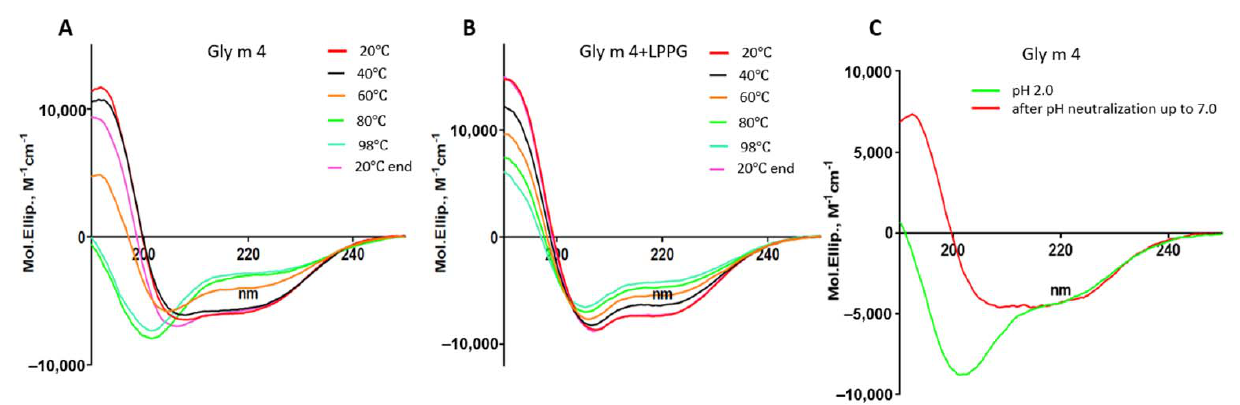
Figure 2. Effects of heating without ( A ) or in the presence of the lysolipid LPPG (at the final concentration of 1 mM) ( B ) and pH change ( C ) on the secondary structure of the soybean allergen Gly m 4. 20 °C end—the CD spectrum of Gly m 4 at 20 °C after cooling down from 98 °C.